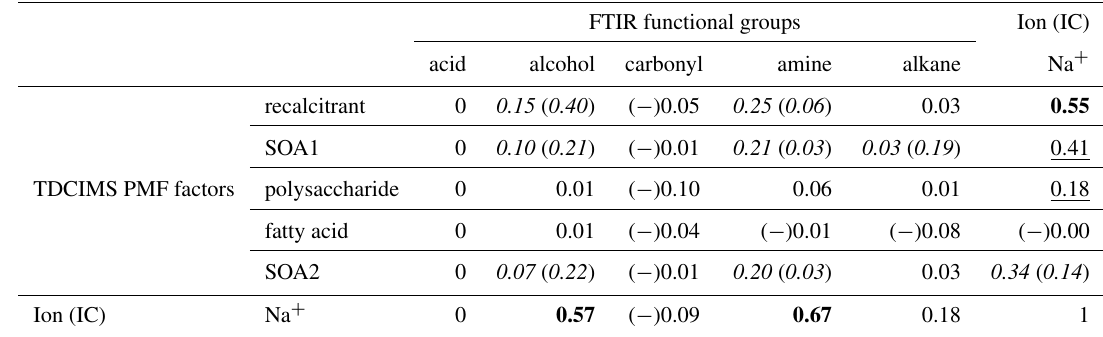
Table 2. Coefficients of determination ( r 2 s) for relationships between TDCIMS PMF factors, TDCIMS Na + , and FTIR organic functional groups for Sea Sweep-generated submicron aerosol. Bold text indicates a strong statistical relationship, with a linear slope 4 standard deviations greater than 0. Underlined text indicates a modest relationship, with a linear slope 2 standard deviations greater than 0. Cases for which removing a single point changes a relationship between none and modest or none and strong are shown as “with (without)” that point and italicized. Relationships for which r is negative are indicated with ( −